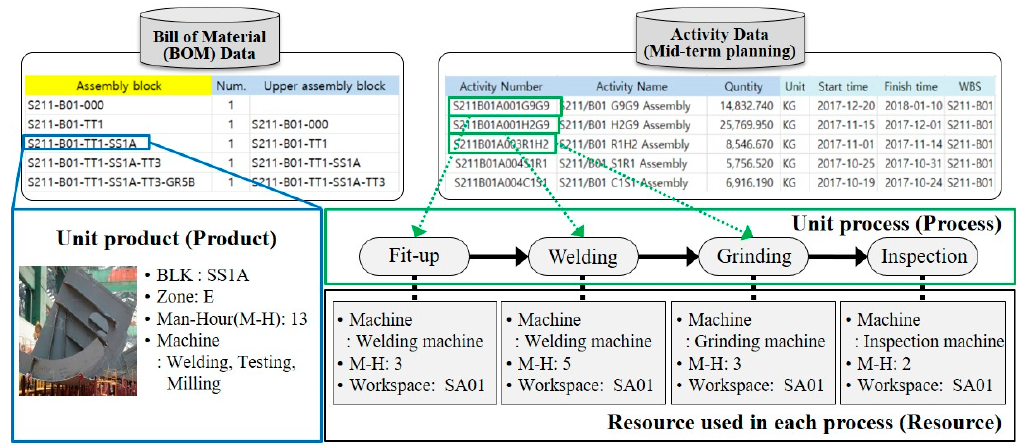
Figure 5. An example of a unit model that combines the products, processes, and resources.